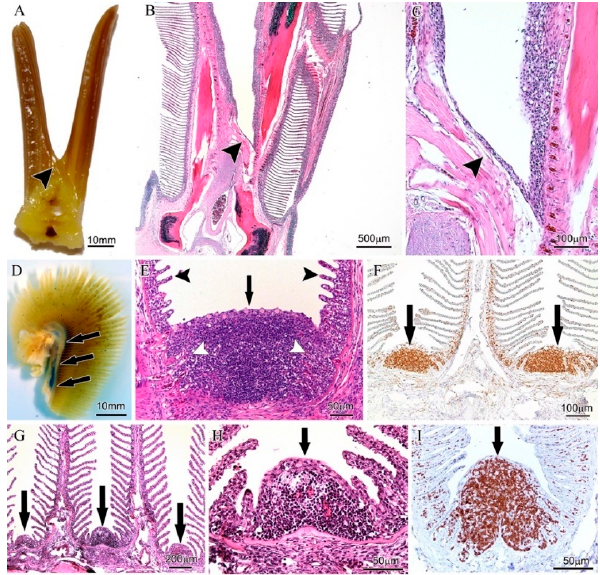
Figure 5. Absence of interbranchial lymphoid tissue (ILT) but the presence of gill-associated lymphoid tissue (GIALT) in the interfilamental space in two Neoteleostian species. ( A–F ) European perch ( P. fluviatilis ). ( A ) Macroscopic image of gill in transversal projection. The arrowhead points to the end of the interbranchial cleft as also seen in ( B , C ). Note the short or missing interbranchial septum. ( B , C ) staining of transversal orientation: no ILT-like structure could be identified in the thin epithelium covering the bottom of the interbranchial cleft. ( D ) Macroscopic image of gill in a lateral projection. ( E , F ) Sagittal orientation: Extensive intraepithelial lymphoid aggregates between the proximal part of the filaments at their attachment to the gill arch. The black arrows in ( D ) show the orientation in the histological sections ( E , F ), pointing to the transition between the gill arch and the filament where the intraepithelial lymphoid aggregates are situated. ( E ) H&E staining; black arrowheads point to free lamellae, while white arrowheads point to lamellar structures embedded within the intraepithelial lymphoid aggregate. ( F ) Immunohistochemical staining using the anti-Zap-70 antibody to indicate Zap-70+ cells (brown). All images were taken from the second left gill arch. ( G–I ) Witch flounder ( G. cynoglossus ). Sagittal orientation: black arrows show orientation in the histological section pointing to the transition between the gill arch and the filament where intraepithelial lymphoid aggregates are situated. ( G–H ) Extensive intraepithelial lymphoid aggregates between the proximal part of the filament at their attachment to the gill arch. ( I ) Immunohistochemical staining using the anti-Zap-70 antibody to indicate Zap-70+ cells (brown). All images were taken from a second left gill arch.